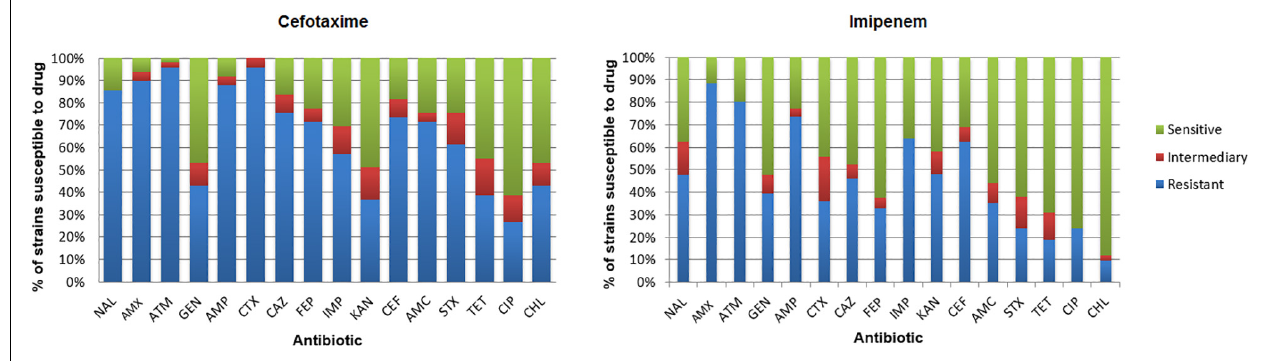
FIGURE 6 | Incidence of resistance to antibiotics among isolates. Amoxicillin (AMX), amoxicillin/clavulanic acid (AMC), ampicillin (AMP), ceftazidime (CAZ), cephalothin (CEF), cefotaxime (CTX), cefepime (FEP), imipenem (IMP), ciprofloxacin (CIP), gentamicin (GEN), chloramphenicol (CHL), sulfamethoxazole/trimethoprim (SXT), kanamycin (KAN), aztreonam (ATM), nalidixic acid (NAL), and tetracycline